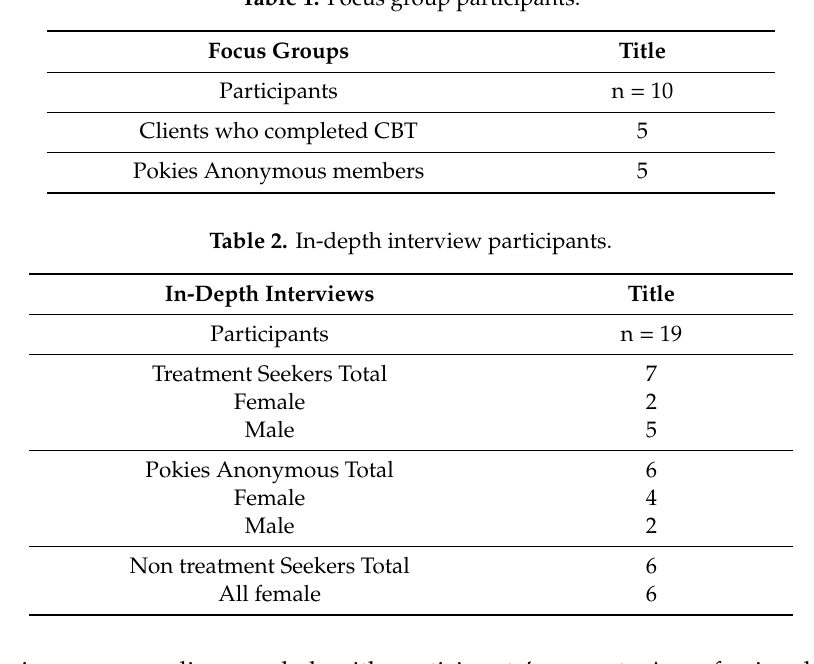
Table 1. Focus group participants.